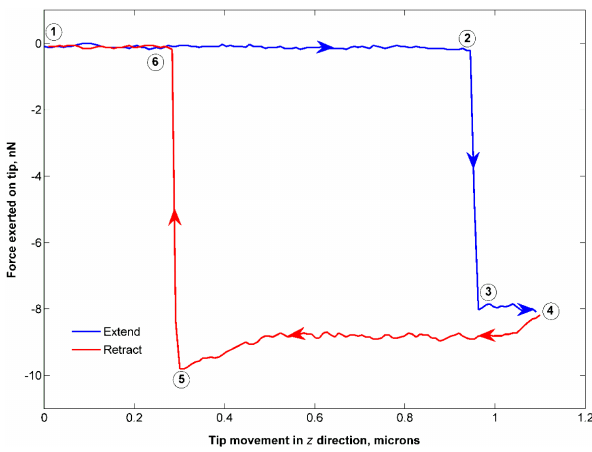
Figure 3. A typical force curve obtained using NaugaNeedle NN- HAR-FM60 probes and an atomic force microscope. The blue line indicates the probe approaching the sample, and the red line indi- cates the probe retracting from the sample. At point 1, the nanonee- dle is approximately 1µm from the surface of the liquid sample. At point 2, the nanoneedle is just above the surface of the liquid. At point 3, the nanoneedle has touched the liquid, which wicks up and exerts a downward force on the probe. At point 4, the nanoneedle begins to pull out of the liquid. At point 5, the liquid is just about to break from the end of the nanoneedle, and the contact angle of the liquid–needle interface approaches zero. At point 6, the nanoneedle has been pulled out of the liquid sample. The probe retracts back to point